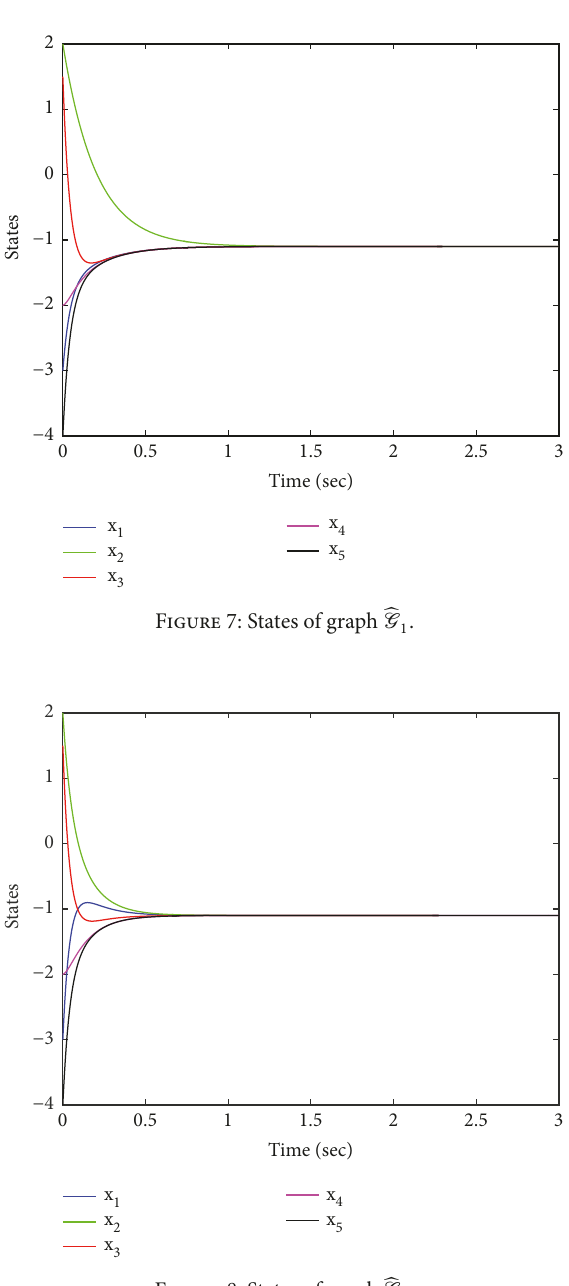
Figure 8: States of graph